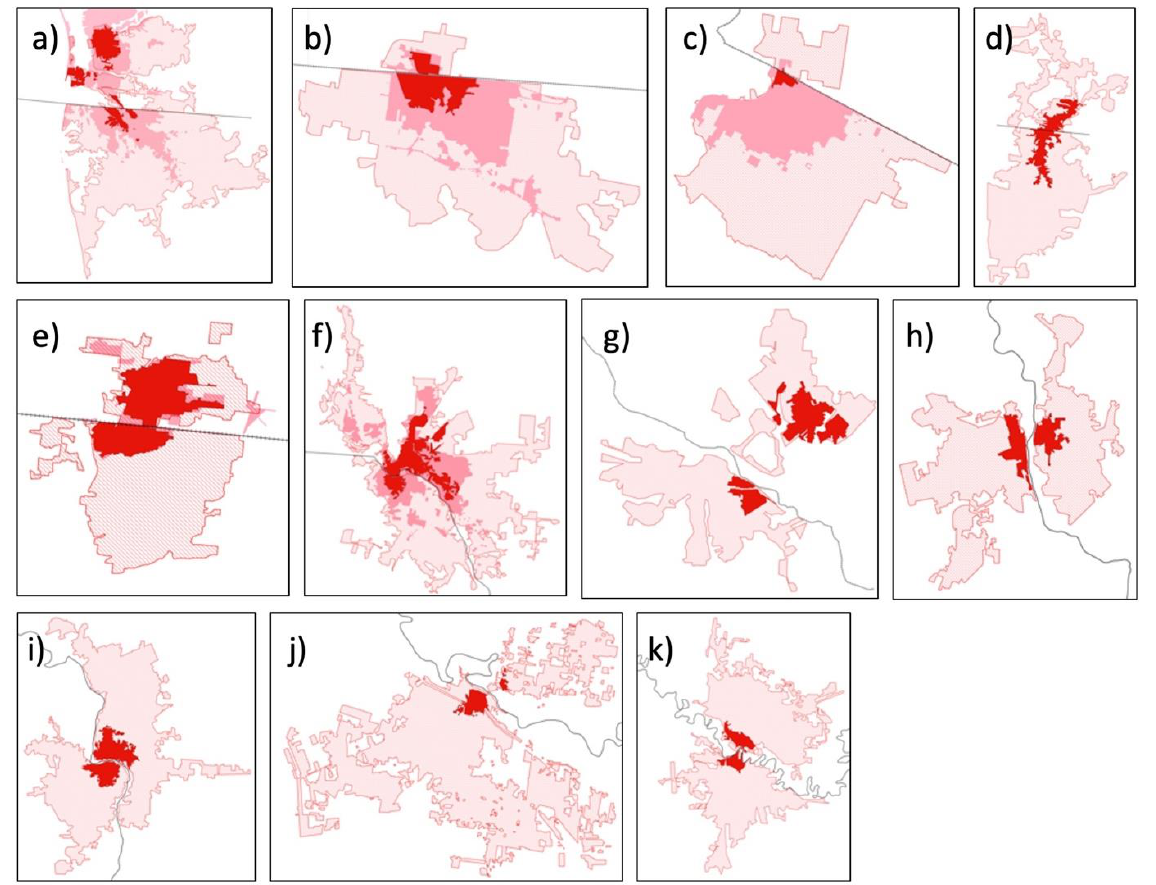
Figure 3. Urban areas and urban growth from the 1940s to 2020 extracted from aerial images, CORONA, and Sentinel 2 satellite images; ( a ) San Diego area and Tijuana 1955, 1972, 2020, ( b ) Mexicali and Calexico 1953, 1976, 2020, ( c ) San Luis Rio C./San Luis 1949, 1972, 2020, ( d ) Nogales 1951, 1976, 2020, ( e ) Agua Prieta and Douglas 1958, 1976, 2020 ( f ) Ciudad Juarez and El Paso 1956, 2020, ( g )